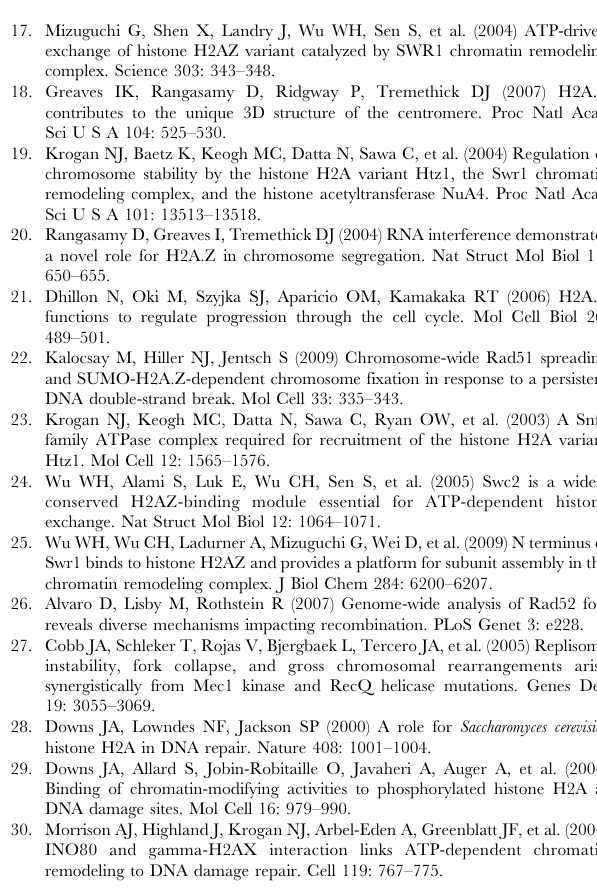
Figure S3 Venn diagrams showing the number of genes that were commonly misregulated (2-fold cutoff) by (A) (htz1 D but no and swr1 D ), (htz1 D and swc2 D ) and (htz1 D and swc5 D ), (C) Figure S4 (A) Swr1-Myc enrichment at the TOA1 promoter as determined by ChIP analysis of samples in Figure 3C. Both I and IP DNA from cell extracts incubated either with anti-Myc antibody or IgG were amplified by real-time PCR (see Table S4 for oligos). The enrichment is graphed relative to the enrichment in the wild-type strain incubated with IgG, taken as 1. Similar results were obtained using as a control an untagged strain incubated with anti-Myc (data not shown). (B) Histone enrichment